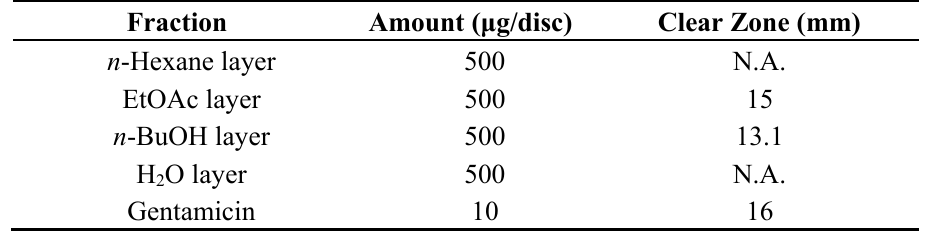
Table 1. Antibacterial activities of each solvent phase obtained from the extract of the leaves of Cornus macrophylla on the growth of P. aeruginosa .